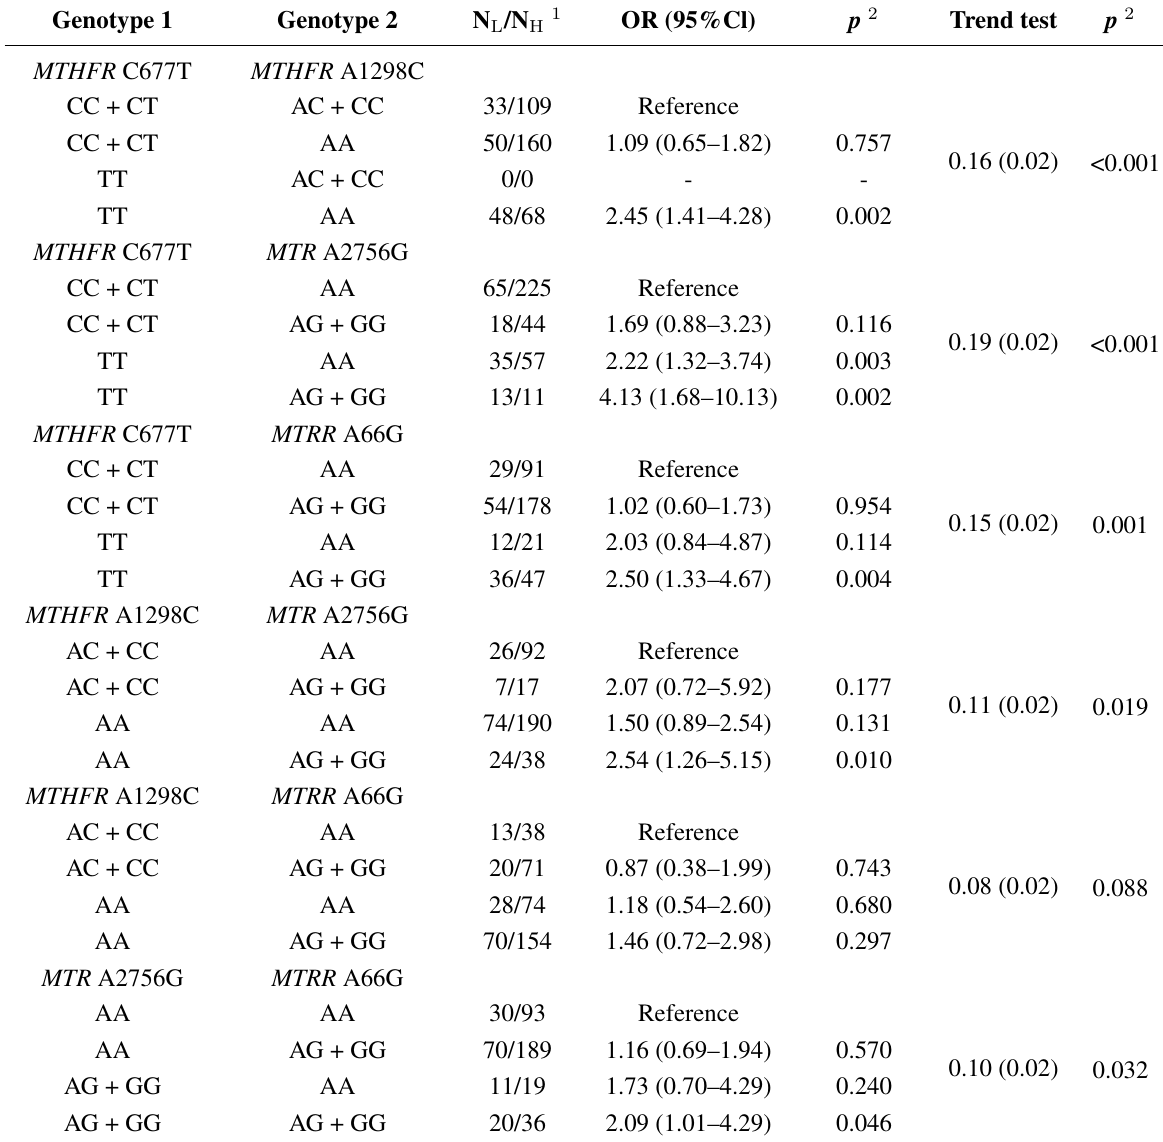
Table 5. Effects of gene-gene interactions on folate